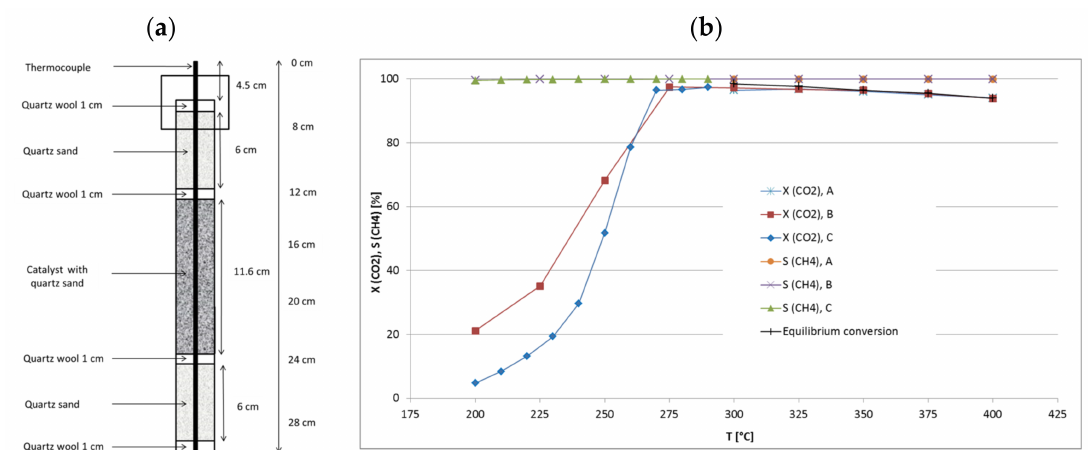
Figure 1. ( a ) Scheme of the bench-scale reactor with catalyst bed (18Ni/Al 2 O 3 ) and quartz fillings. ( b ) CO 2 conversion and CH 4 selectivity in runs with different catalyst loadings (run A: 1 mL of catalyst; run B: 2.5 mL of catalyst; run C: 4 mL of catalyst) in dependence on temperature.